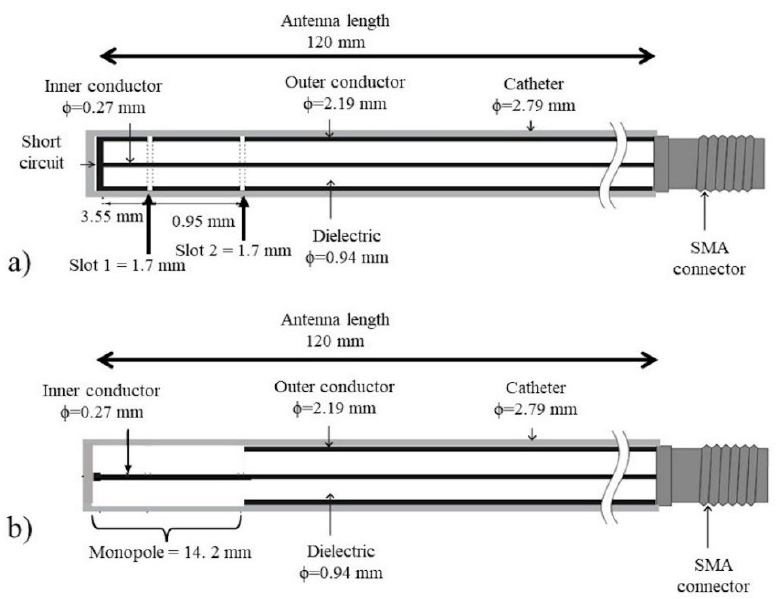
Figure 2. Proposed antennas, ( a ) double slot antenna and ( b ) monopole antenna.